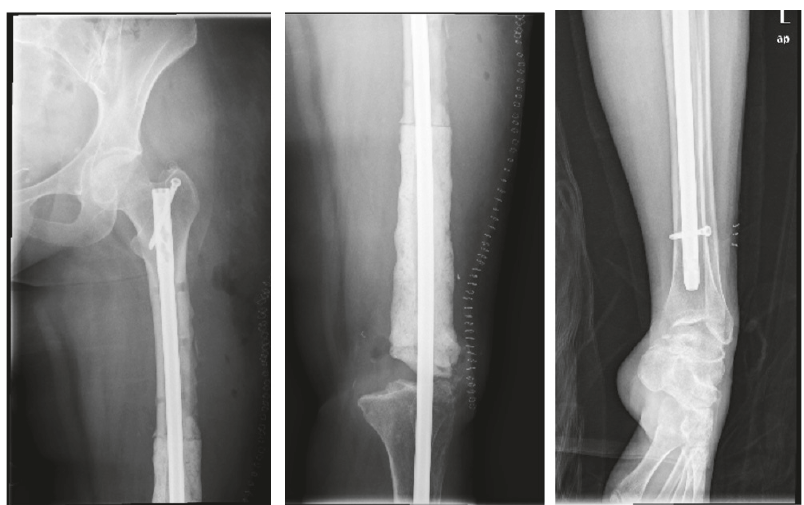
Figure 7: Postoperative radiographs with long IM nail and surrounding bone cement.